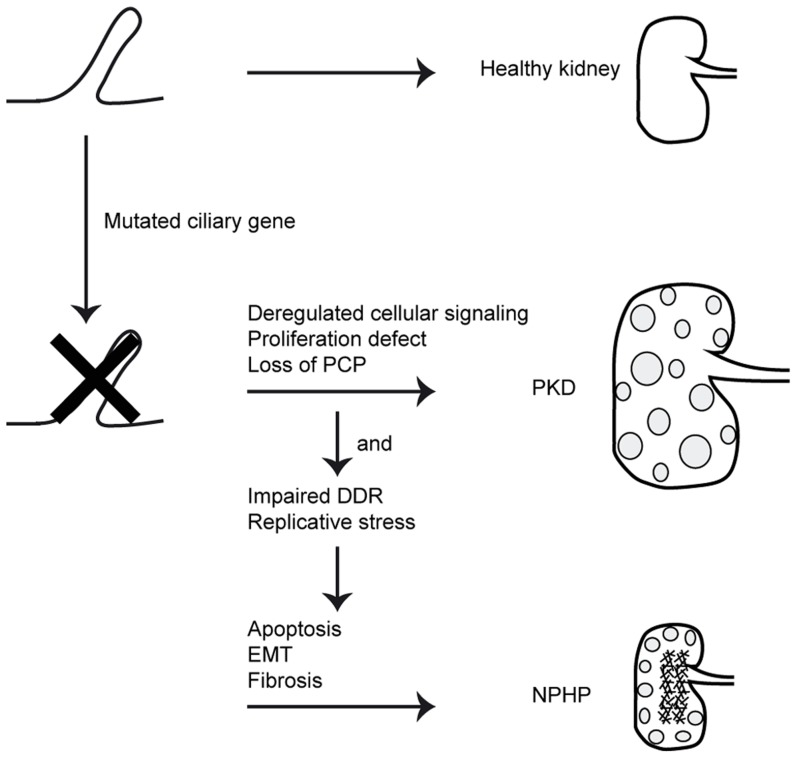
Schematic overview of signaling cascade involved in development of PKD and NPHP.Mutations in ciliary genes cause ciliary defects. Ciliary defects result in proliferation defects, loss of planar cell polarity (PCP) and deregulated cellular signaling. This causes cystic kidney disease. When the gene mutated is also involved in the DNA damage response (DDR) or DNA replication, impairments of these processes cause apoptosis, epithelial-to-mesenchymal transition (EMT) and consequently fibrosis in the NPHP patients.